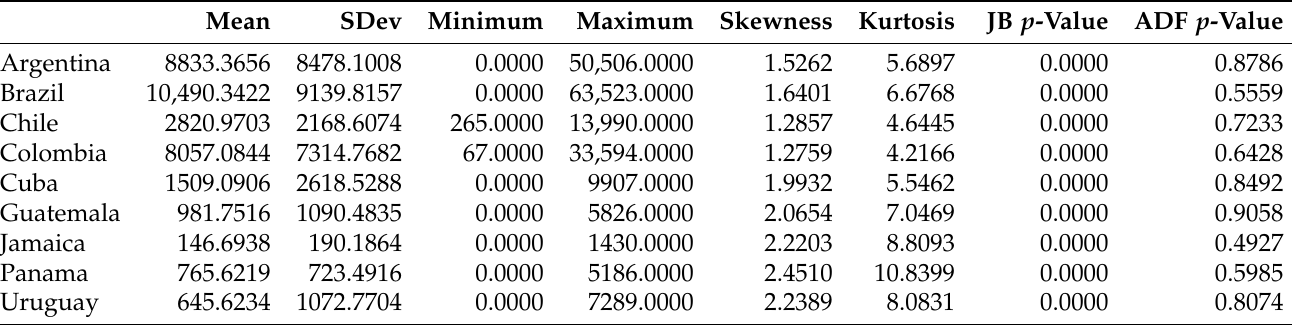
Table 1. Descriptive statistics, JB test, and ADF test for new COVID-19